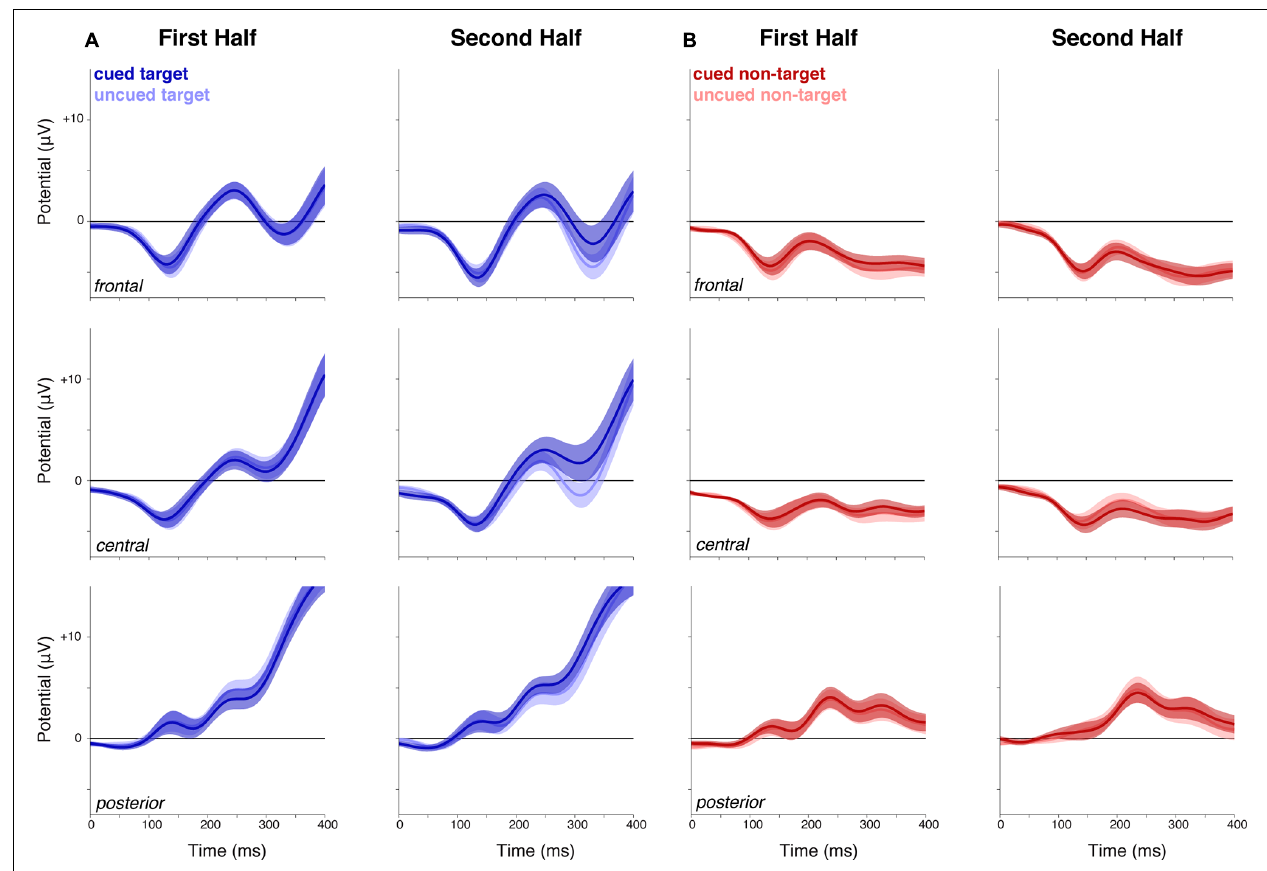
uncued targets in the second half (right panels) at central and posterior sites. However, this did not survive cluster correction. (B) Cued and uncued non-targets. There was no evident difference between ERPs for cued and uncued non-targets. Shaded areas indicate SEM. ROIs are shown in Figure 2